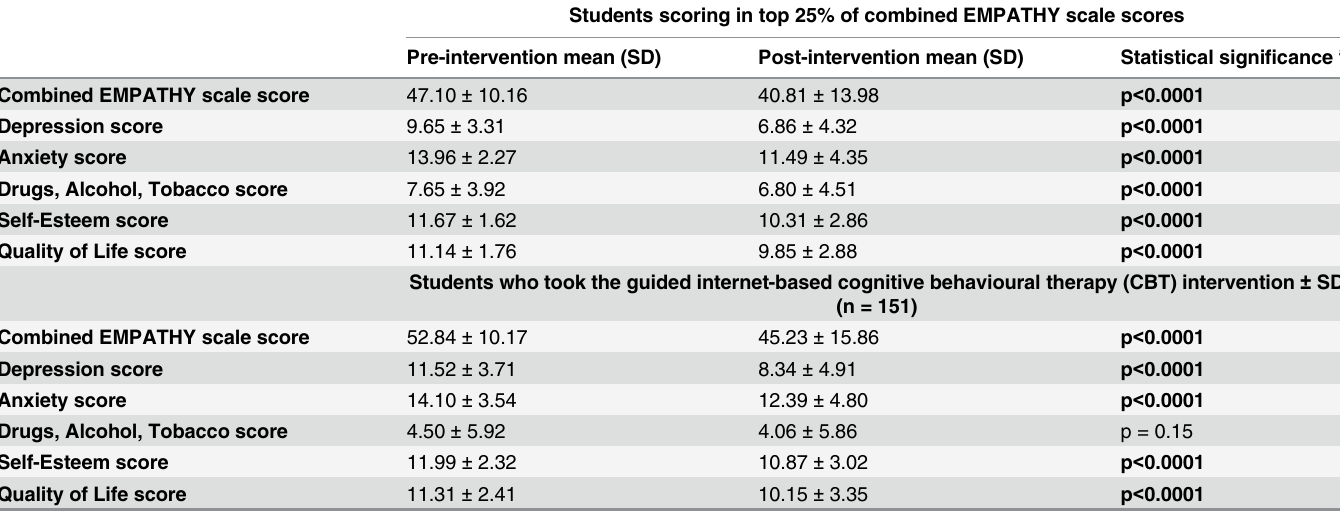
Table 5. Change in scores from baseline to follow-up for those scoring in top 25% of combined EMPATHY scale